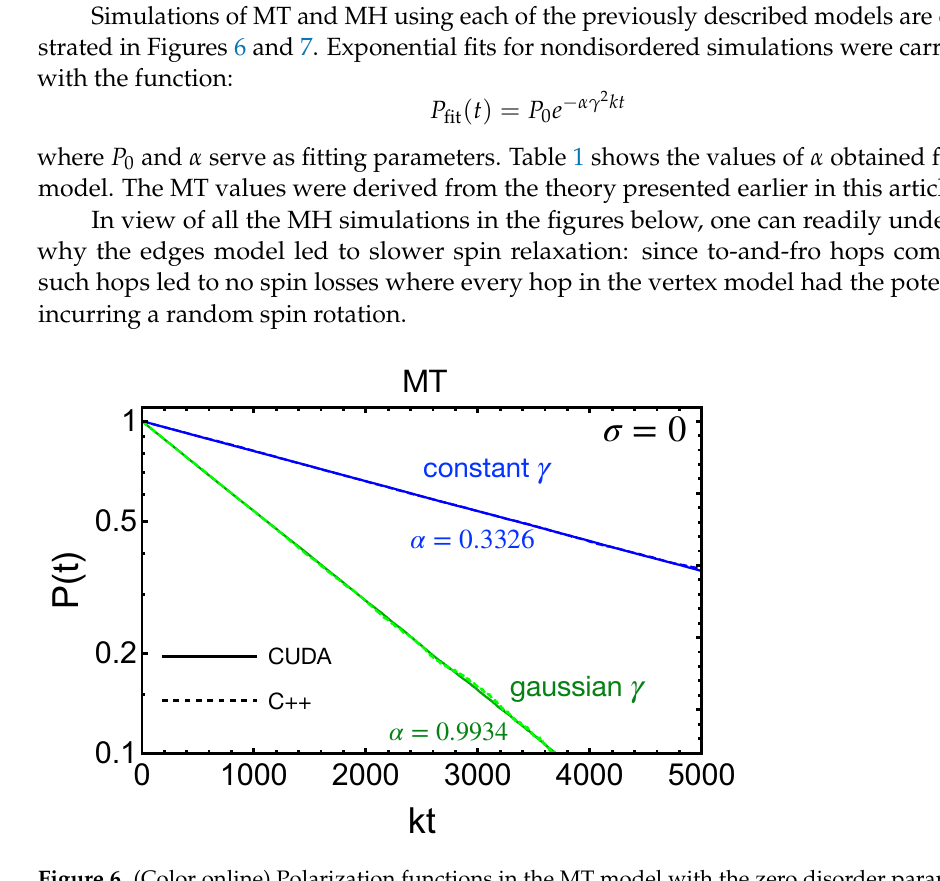
Figure 6. (Color online) Polarization functions in the MT model with the zero disorder parameter, σ , for two different models of the local fields, γ : constant magnitudes (blue) and Gaussian magnitudes (green). The spin relaxation rate fit constants, α , are given for each (see Equation (24)). The α values agree well with the theoretical values of 1/3 and 1. Two simulations were compared-: one programmed serially in C++ and the other in parallel with CUDA. Their differences are nearly imperceptible (the difference between solid and dashed lines). Additional parameters used in the simulations were γ = 0.025 (for the Gaussian approximation γ , it is the width of the distribution) and k = 1. The C++ (CUDA) simulation is averaged over 20 k(200 k) configurations. Table 1. Rational approximations for the values of α , found computationally, when σ = 0. Values preceded by “ ∼ ” denote rationalizations of numerical results (in other words, these values are not derived